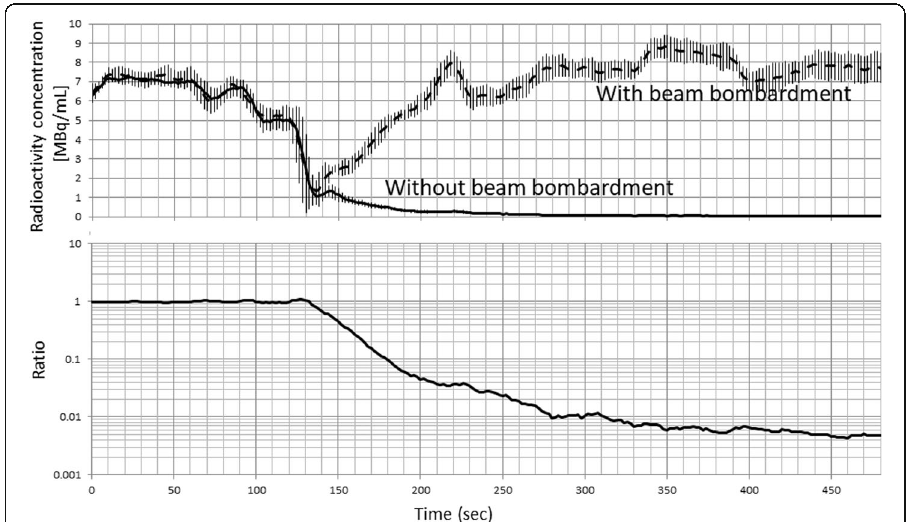
Fig. 4 Time-activity curves of RD1 in Fig. 1 with and without cyclotron beam bombardment for the second supply of C 15 O 2 (upper). Ratio of the two curves indicates the fractional contamination in the C 15 O 2 radioactivity from the previous production of 15 O 2 (lower). Note that the time scale is given after initiation of the 15 O 2 supply to the face